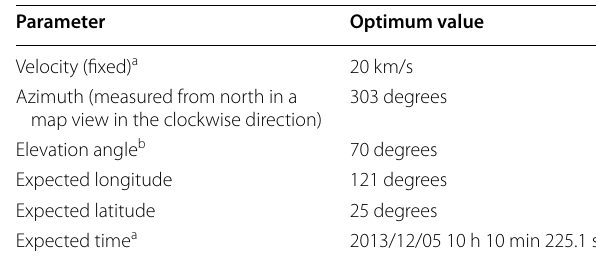
Table 1 List of the best parameters constraining the tra- jectory of the meteor, inverted using the Genetic